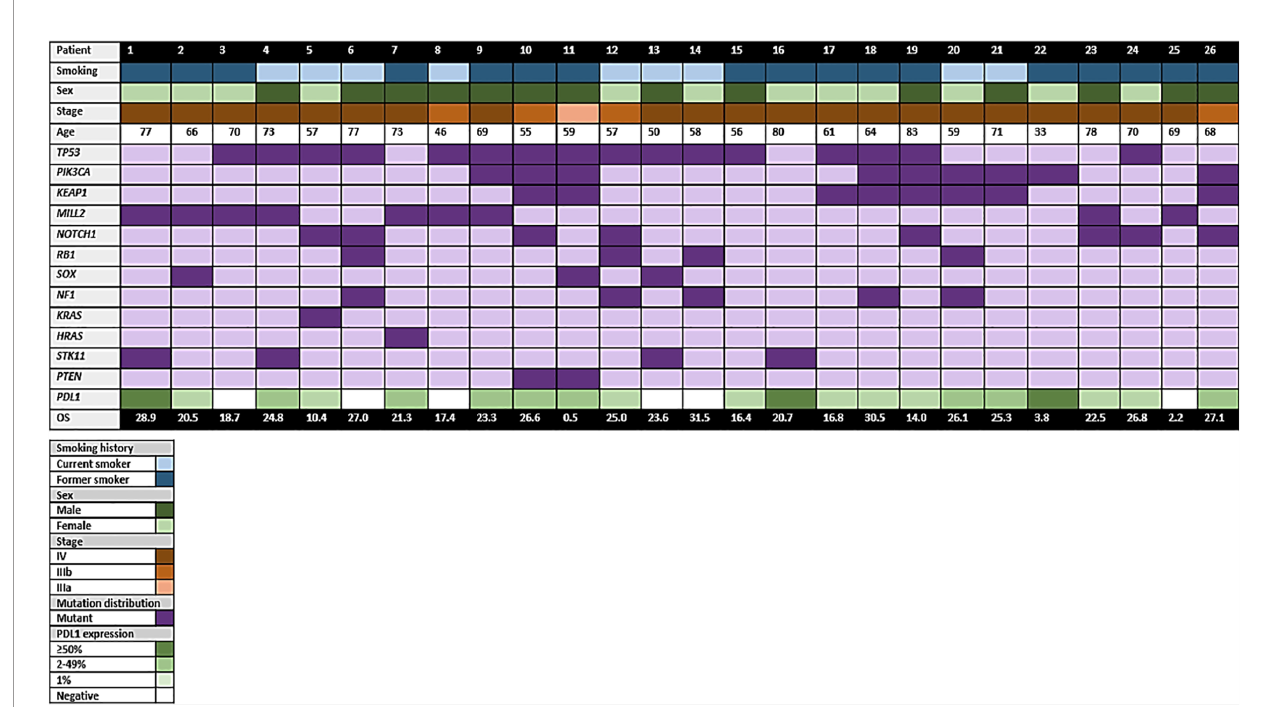
FIGURE 1 | Diagram highlighting the main characteristics of the patients included in the